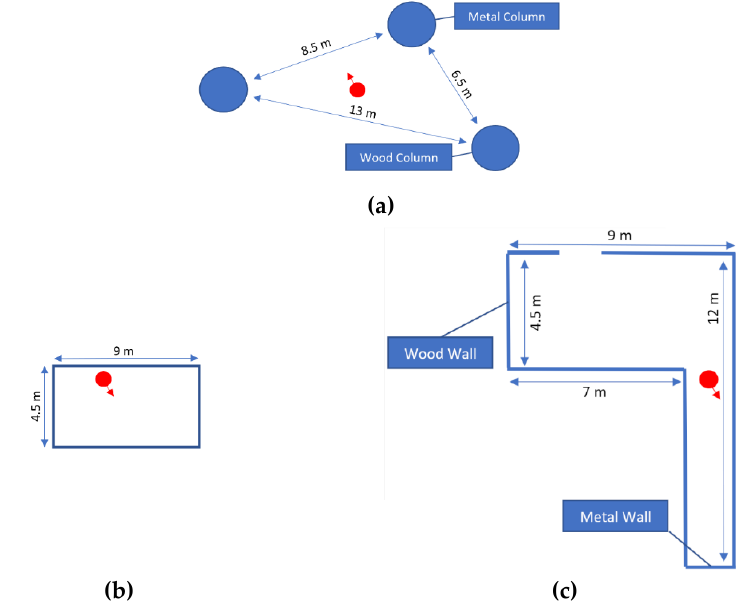
Figure 6. Scenarios for tests 1 ( a ), 2 ( b ) and 3 ( c ). The default material is “brick”. The starting position and orientation are represented by a red dot and red arrow, respectively.